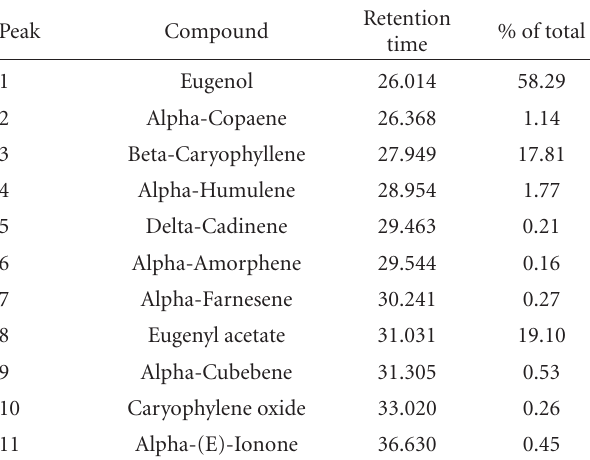
Table 1: GC-MS analysis of essential oil of